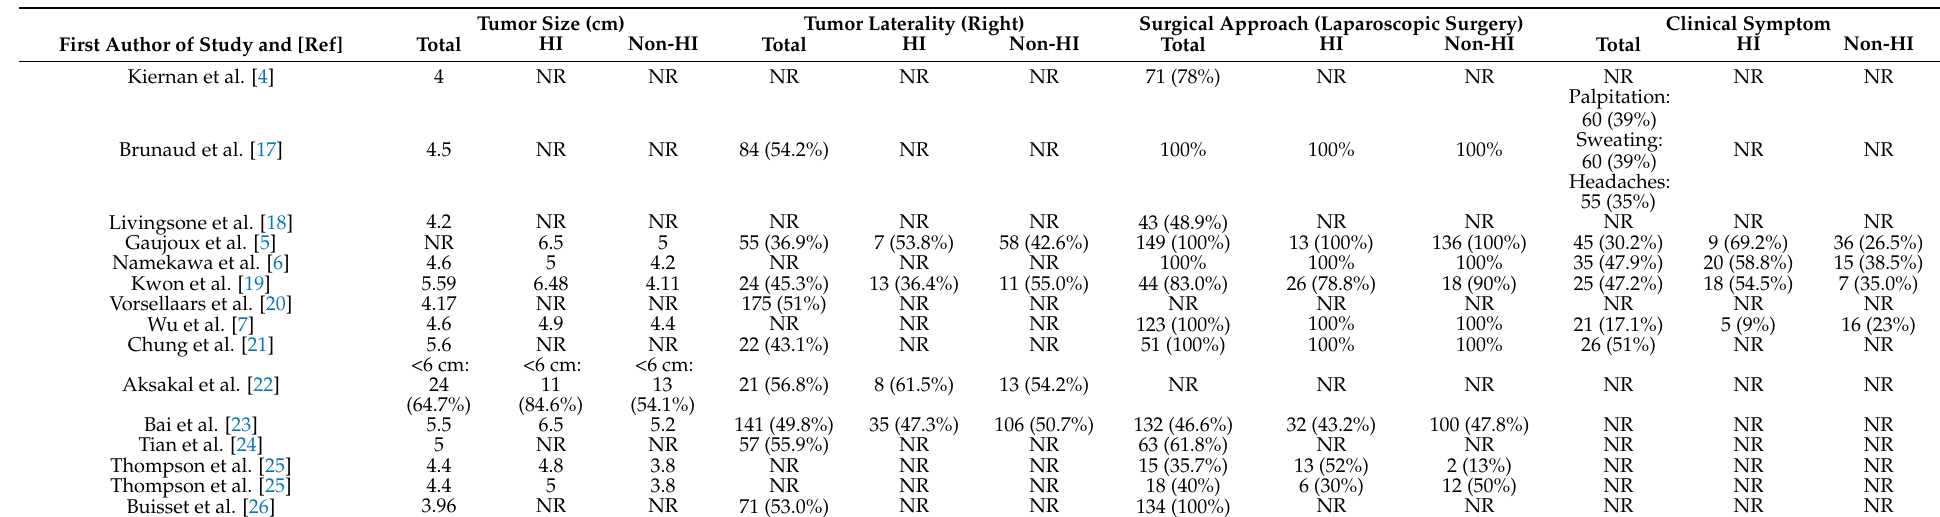
Table 3. The characteristics of tumor and surgical